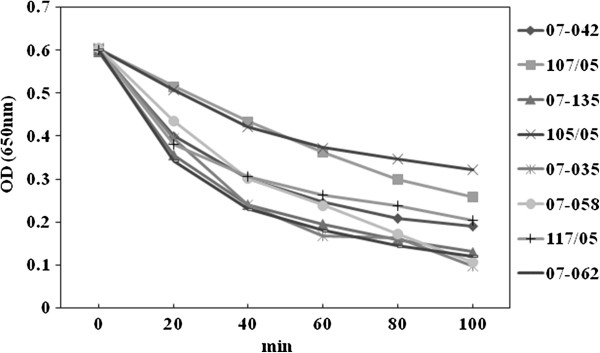
Autolysis assays for USA400-related isolates. 07–058, 105/05, 107/05 are strong biofilm producers; 07–035, 07–042, 07–135 moderate; and 07–062, 117/05 weak producers.